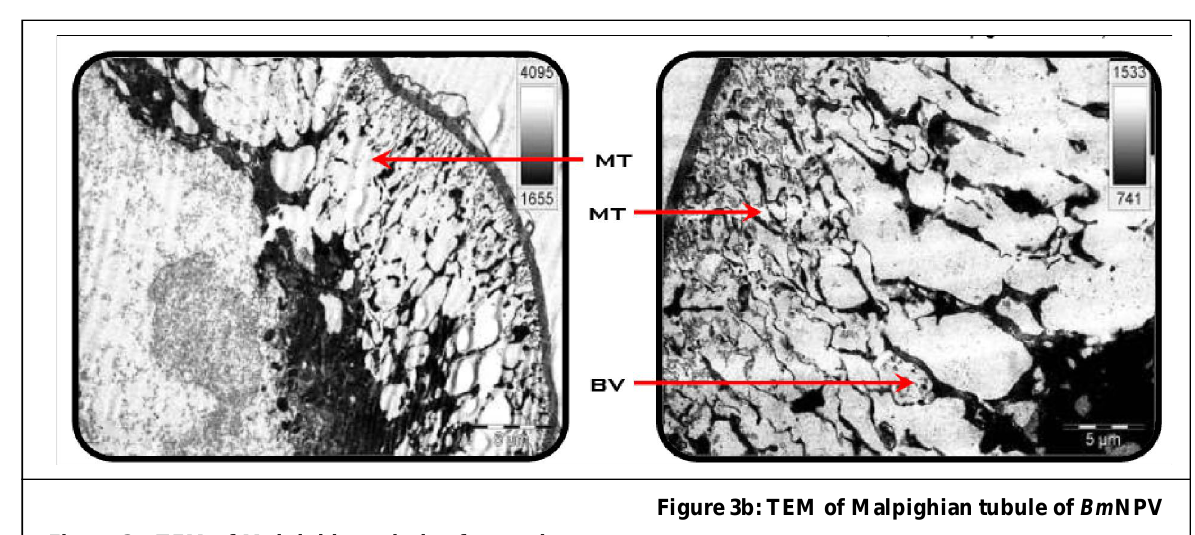
Figure 2b: SEM of Bm NPV infected larval Malpighian tubule cross sectional view in advanced stage (×1400, DGC: Deformed Guanine Cell, MT: Malpighian Tubule)